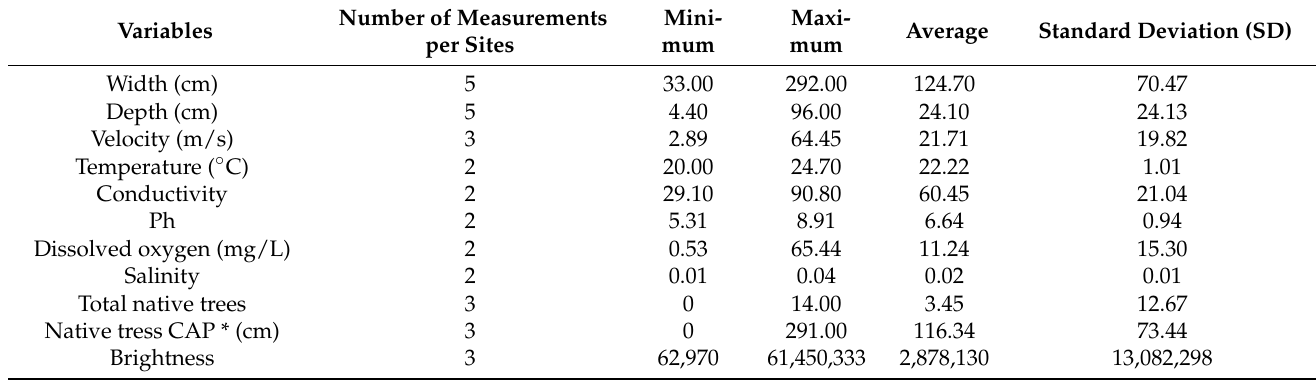
Table A2. Measurements of local environmental variables (minimum and maximum values, average, and standard deviation) in the cacao-cabruca areas, in the streams sampled in the southern region of Bahia.